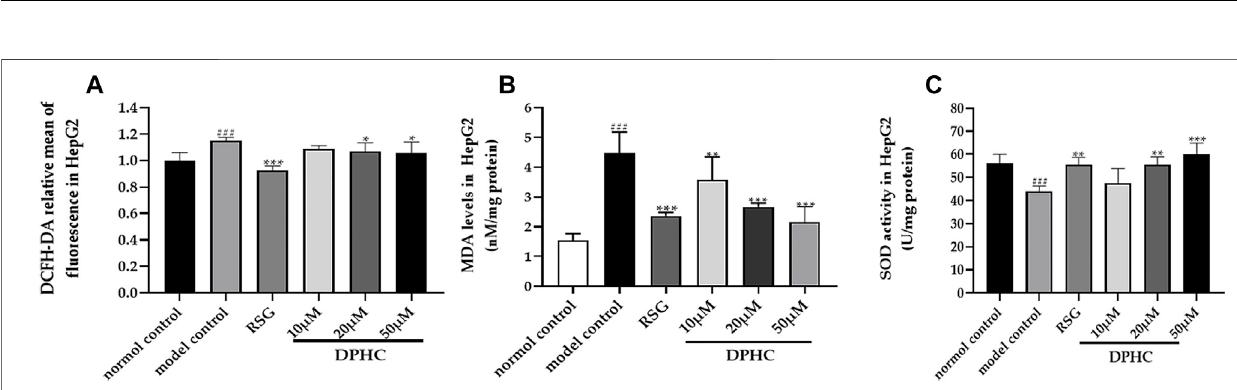
Frontiers in Pharmacology |